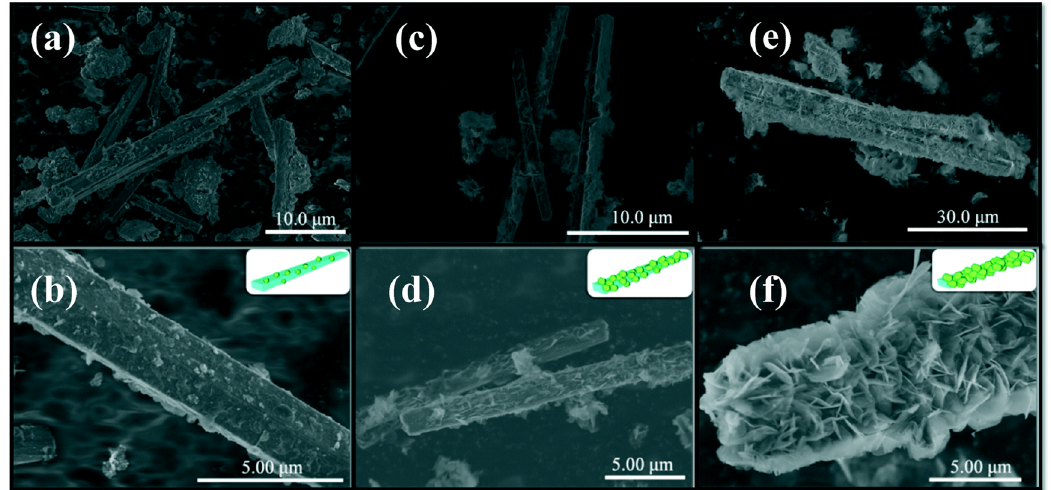
Figure 15. SEM images of MgAl-LDO/TiO 2 catalysts: ( a , b ) 8% MgAl-LDO/TiO 2 , ( c , d ) 10% MgAl- LDO/TiO 2 , and ( e , f ) 12% MgAl-LDO/TiO 2 [100].